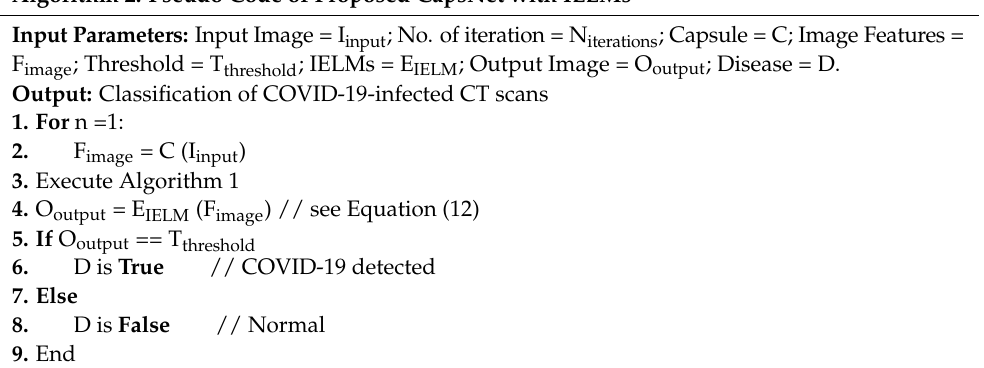
Algorithm 2: Pseudo Code of Proposed CapsNet with